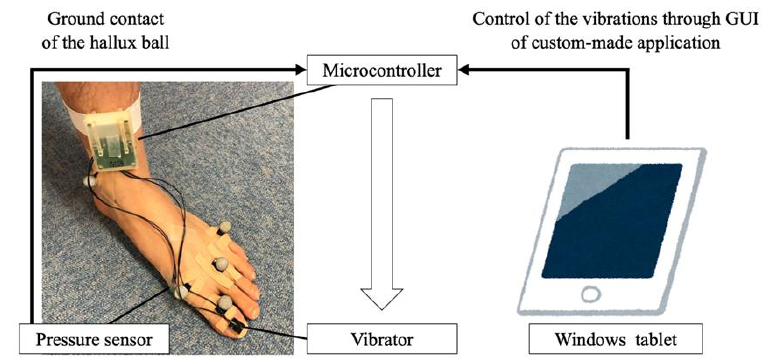
Figure 1. Vibration system used in this study. The vibrator, pressure sensor, and microcontroller were attached on the nail of the hallux, hallux ball, and distal end of the shank, respectively. The vibration was controlled through the graphical user interface of a custom-made application running on a Windows tablet.